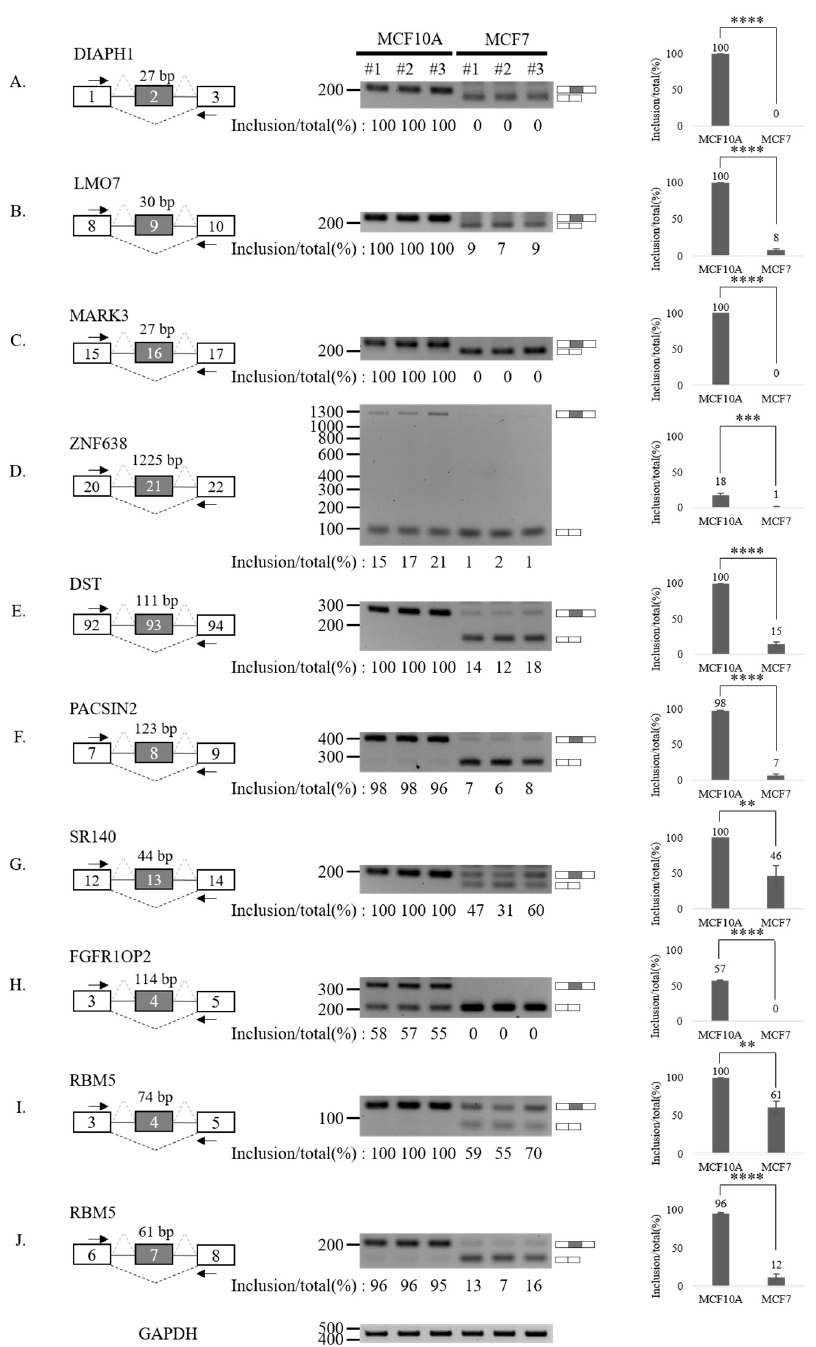
Figure 4. Validation of AS down-regulated cassette exons in human breast cancer cells. ( A – J ) (Left) For each gene, the schematic representation of the genomic region containing the AS cassette exon is shown. Exon numbers are shown in the gray boxes. The length of AS cassette exons is shown above the exon. Inclusions of cassette exons are shown with dotted grey lines. Skipping events are shown with dotted black lines. Arrows indicate primers used in RT-PCR. (Middle) RT-PCR analysis (in triplicated) of the AS profile of cassette exons was performed by using RNA extracted from human breast cells. Quantitation results are shown at the bottom of each gel. (Right) Statistical analysis graphs of RT-PCR. Error bars = standard deviation (SD) calculated from three independent experiments. **** p < 0.0001, *** p < 0.001, ** p < 0.01. Uncropped figures are shown in Supplementary Figure